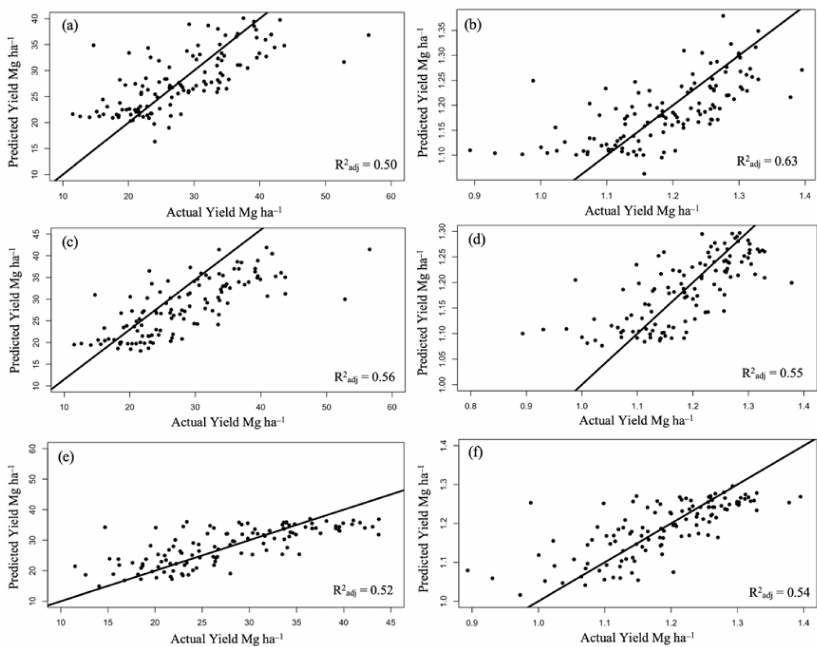
Figure 8. Relationship between the actual and predicted total potato yield for ( a ) the first flight on 25 June, the untransformed model; ( b ) the first flight on 25 June, the transformed model; ( c ) the third flight on 9 July, the untransformed model; ( d ) third flight on 9 July, the transformed model; ( e ) the sixth flight on 29 July, the untransformed model; ( f ) the sixth flight on 29 July, the transformed model.